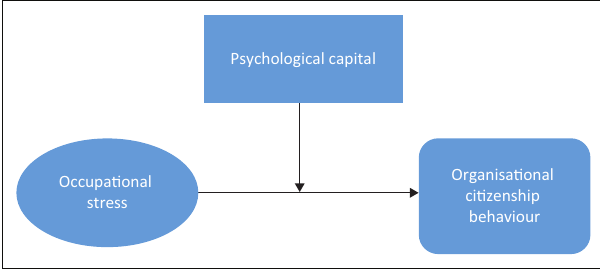
FIGURE 1: Psychological capital as a moderator of the relationship between occupational stress and organisational citizenship